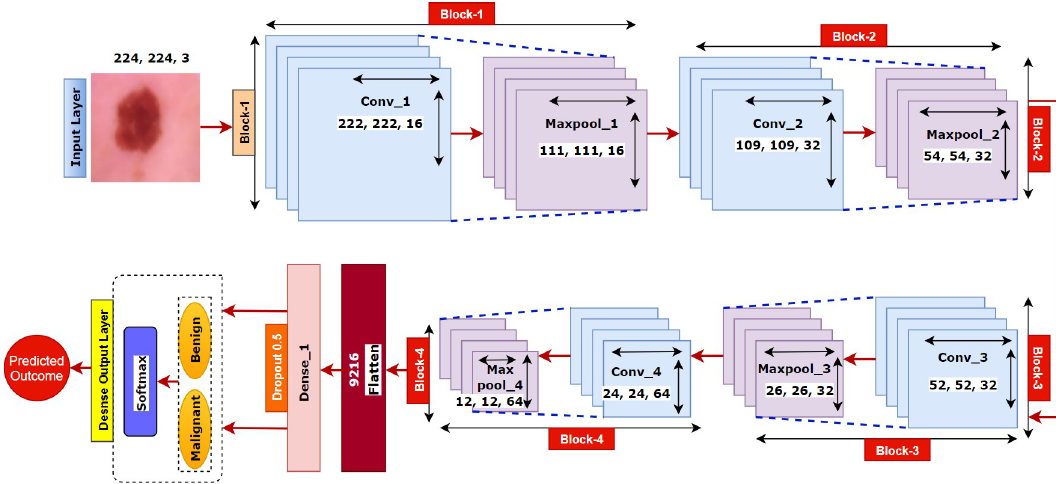
Fig 21. Architecture of proposed SCNN_12